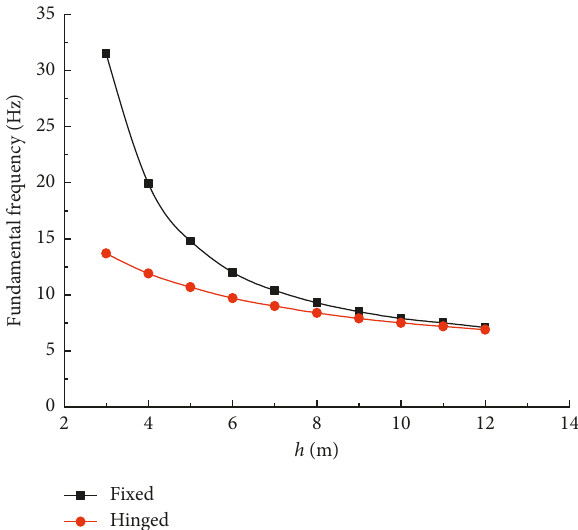
Figure 8: Effects of boundary condition of wall facing on fun- damental